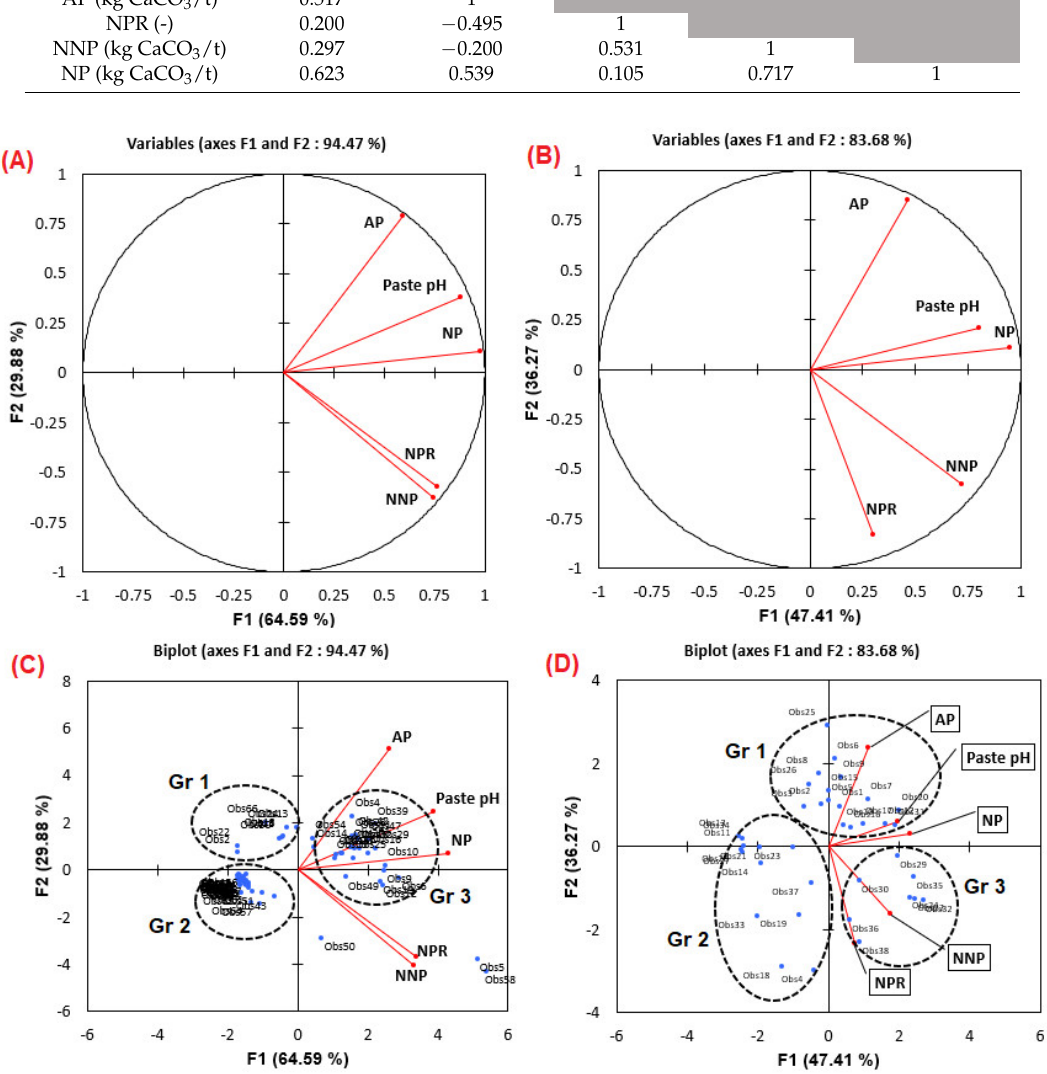
Figure 10. PCA plots for: ( A ) the southern zone and ( B ) the northern zone. Clustering of samples for: ( C ) the southern zone and ( D ) the northern zone.